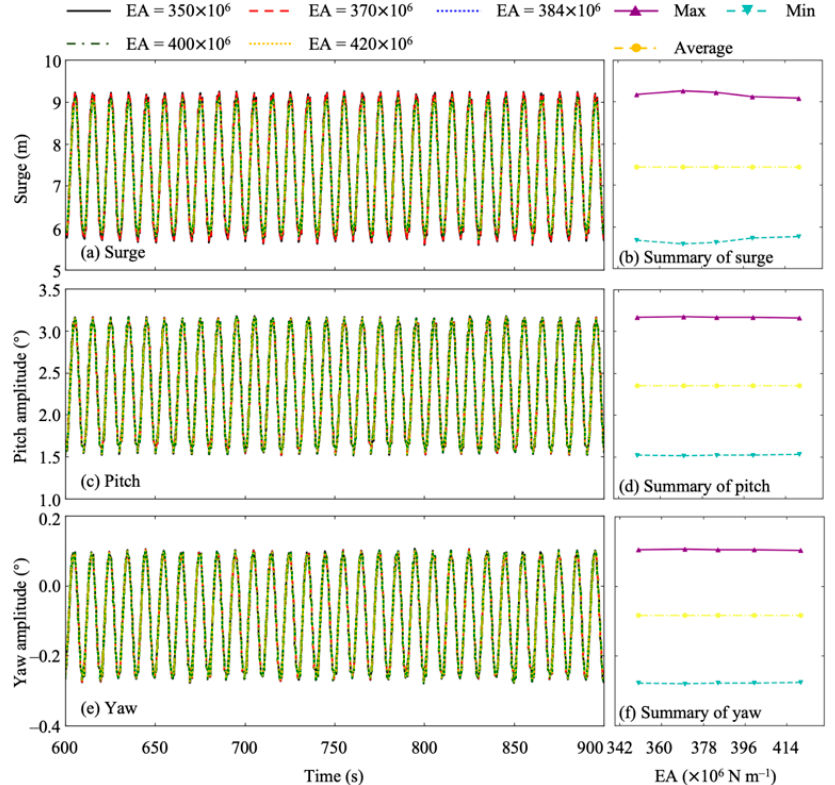
Figure 16. Wind turbine surge, pitch, and yaw movements with different mooring line stiffnesses when under regular wave case C1: ( a , b ) surge movement; ( c , d ) pitch movement; ( e , f ) yaw move- ment.